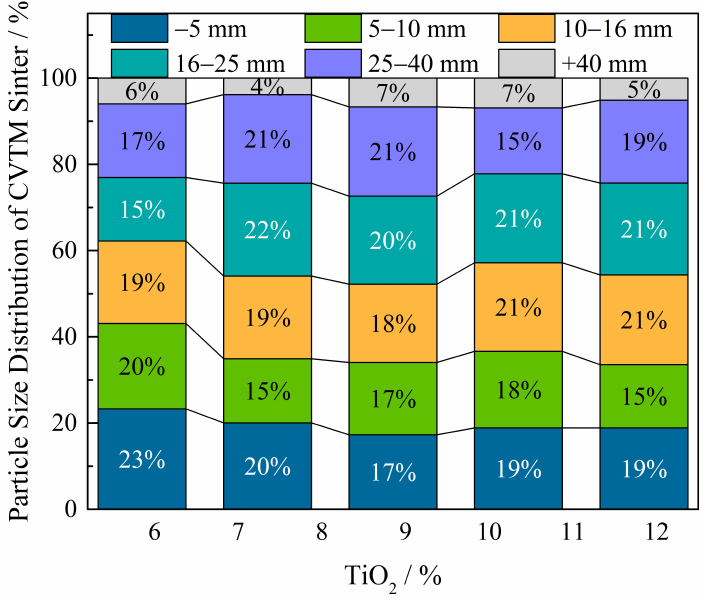
Figure 7. Particle size distribution of CVTM sinters with different TiO 2 content.